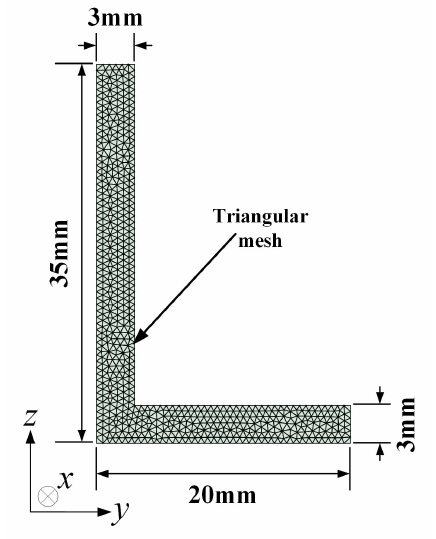
Figure 2. Cross-section diagram of the SAFE model for a